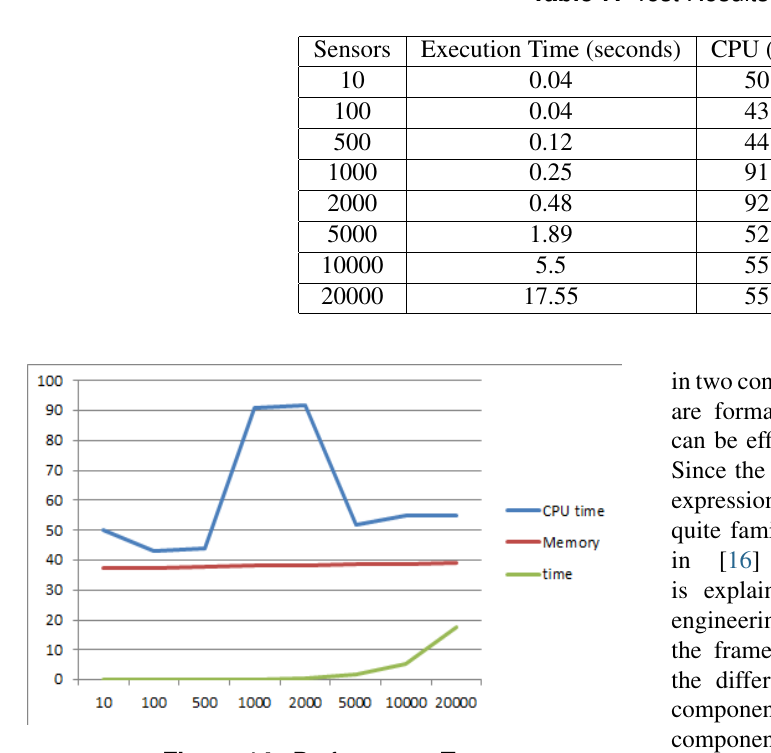
Table 7. Test Results